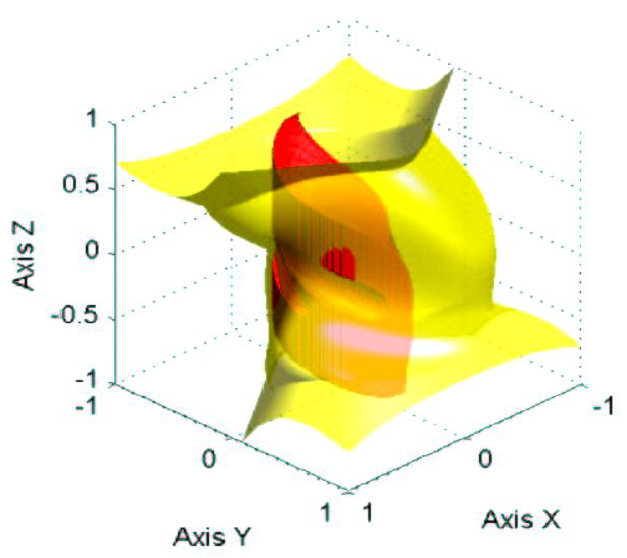
Figure 3. Workspace (red surface) and singularities (yellow surface) of the parallel mechanism. In this figure, almost all the of the singularity surface is placed outside the workspace. There are very few singularities in the possible rotation of the parallel mechanism.